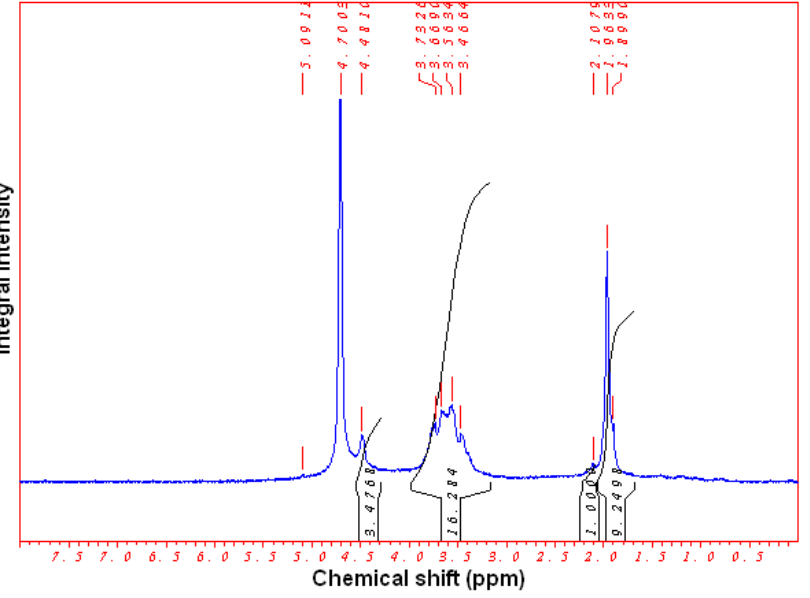
Figure 8. 1 H-NMR spectrum of the chitin treated in the oxygen for 15 min.